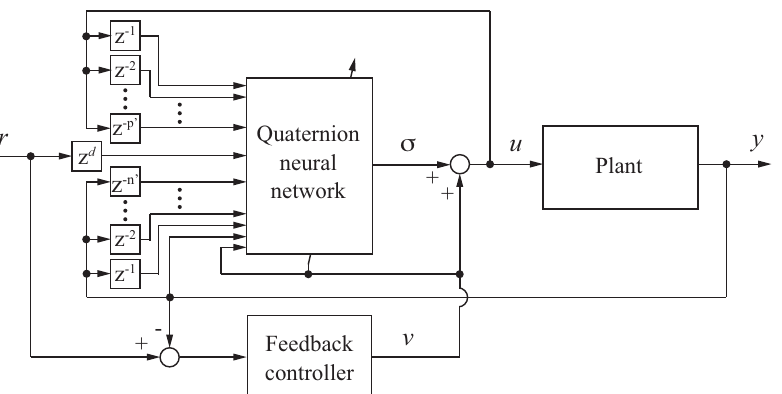
Figure 1. Schematic of a QNN-based feedforward–feedback controller, where z is a shift operator, n (cid:48) = n − 1 and p (cid:48) = p −